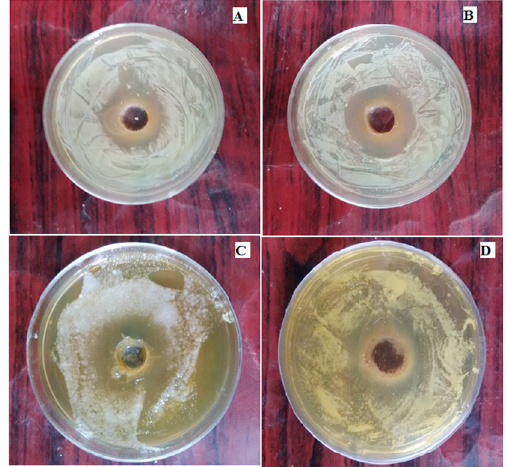
Fig. 3. Antibacterial and antifungal activity of isolated